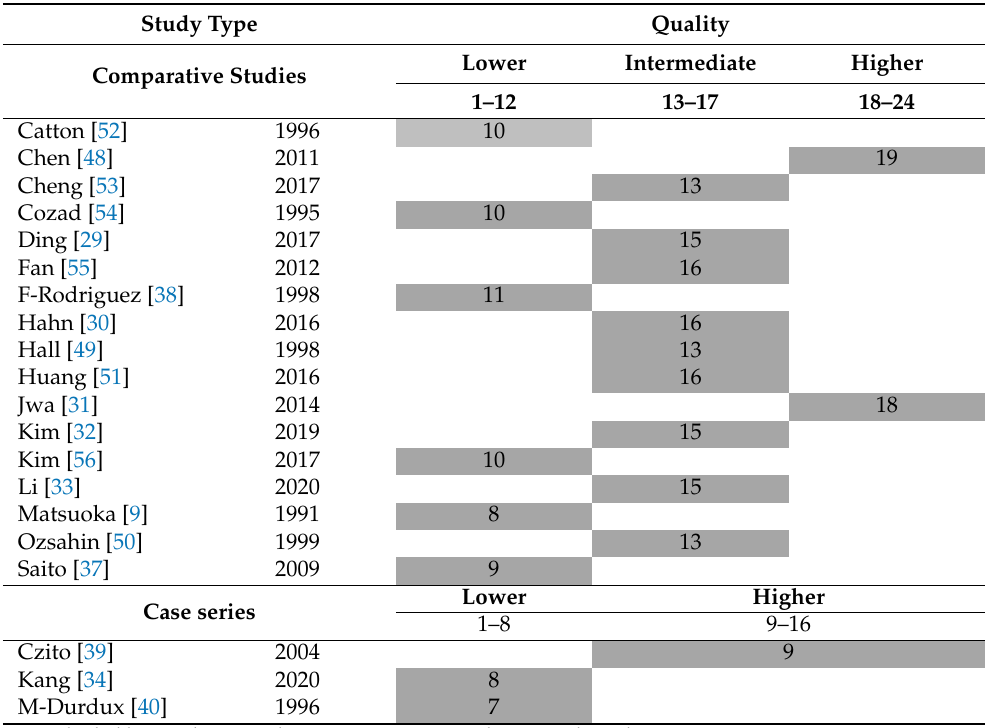
Note: shaded bars indicate quality category corresponding to each study